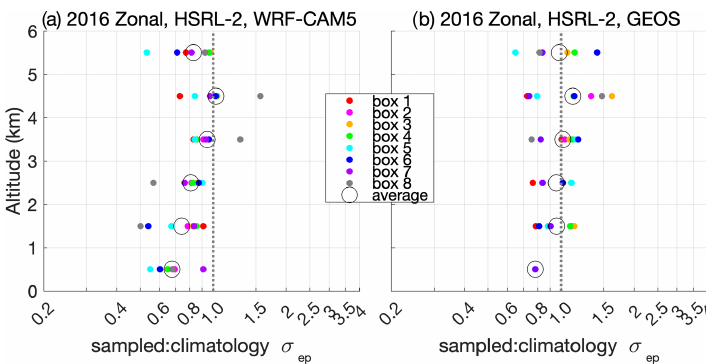
Figure 5. As in Fig. 3 but for the 2016 zonal transect and for the HSRL-2 retrievals of σ ep